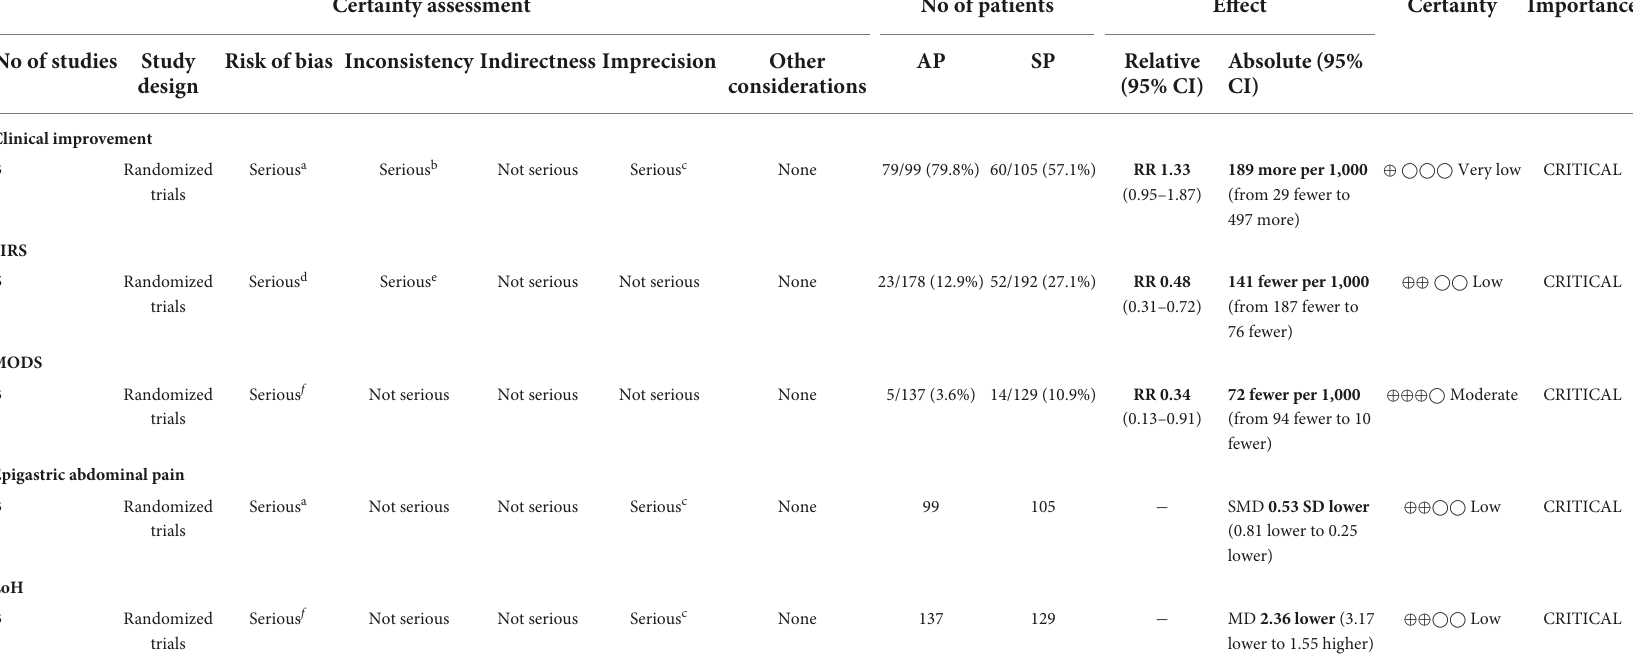
TABLE 2 Summary of findings based on GRADE